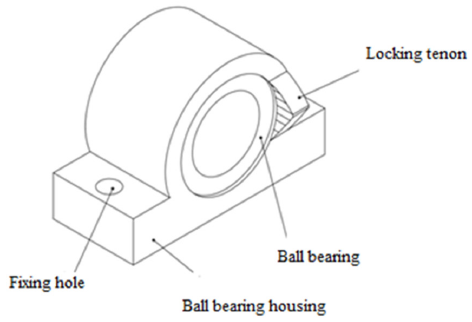
Figure 7. The first part of the shoulder joint.